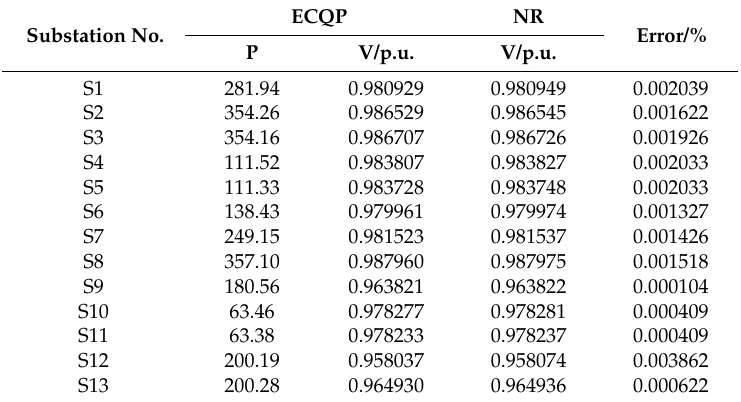
Table 2. Extended cone quadratic programming (ECQP)-based solution accuracy verification.